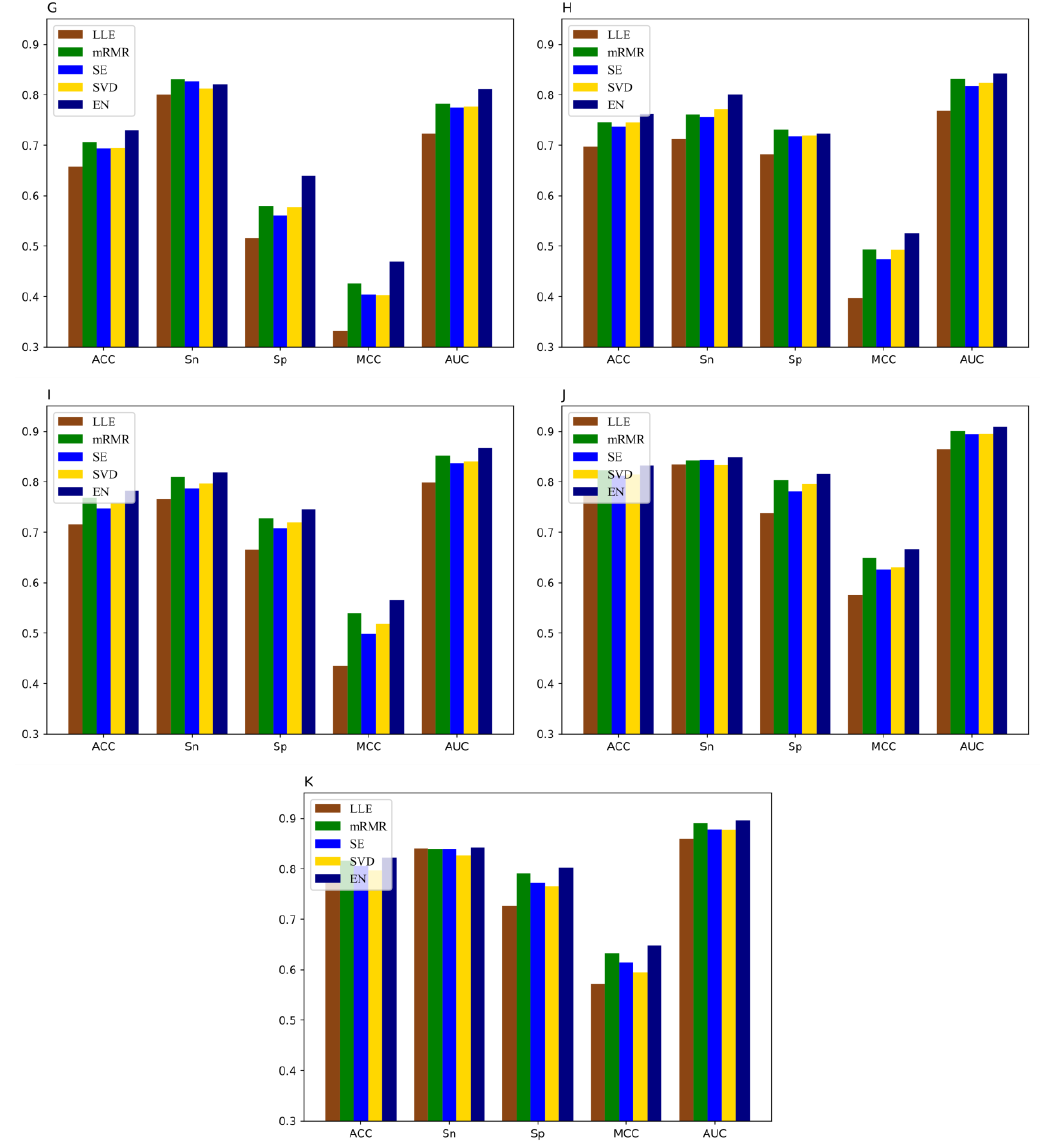
Figure 5. Performance of different feature selection methods on eleven datasets ( A ) H_B, ( B ) H_K, ( C ) H_L, ( D ) M_B, ( E ) M_H, ( F ) M_K, ( G ) M_L, ( H ) M_T, ( I ) R_B, ( J ) R_K, and ( K ) R_L.